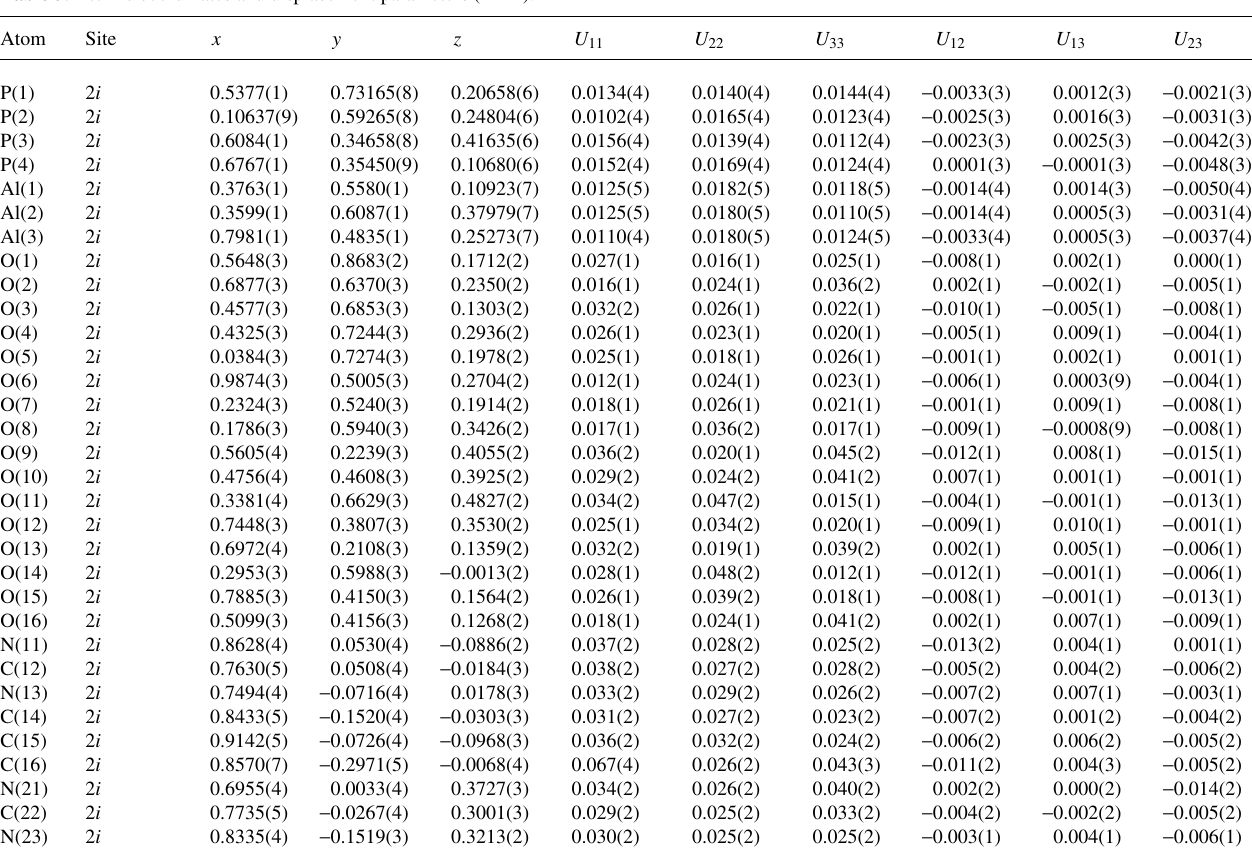
Table 3. Atomic coordinates and displacement parameters (in Å 2 ) .